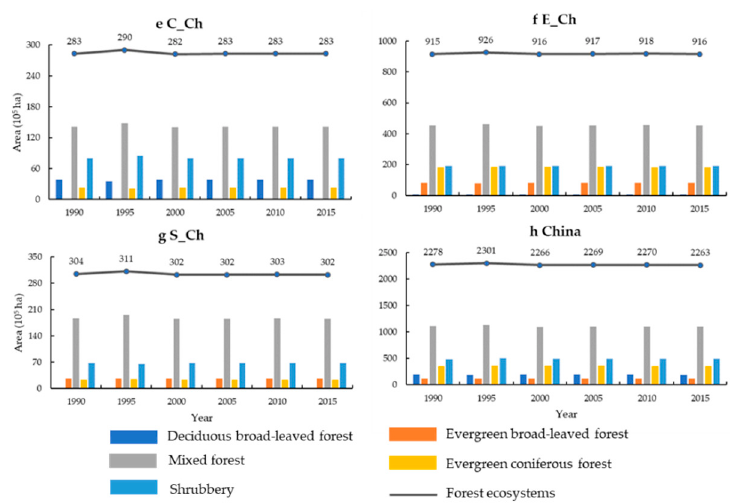
Figure 2. The area changes of China’s forest ecosystems during 1990–2015. The acronyms in ( a – h ) are Northeast China (NE_Ch), Inner Mongolia (IM_Ch), Northwest China (NW_Ch), Qinghai-Tibet (QT_Ch), Central China (C_Ch), East China (E_Ch), South China (S_Ch), and China, respectively. Forests 2020 , 11 , x FOR PEER REVIEW